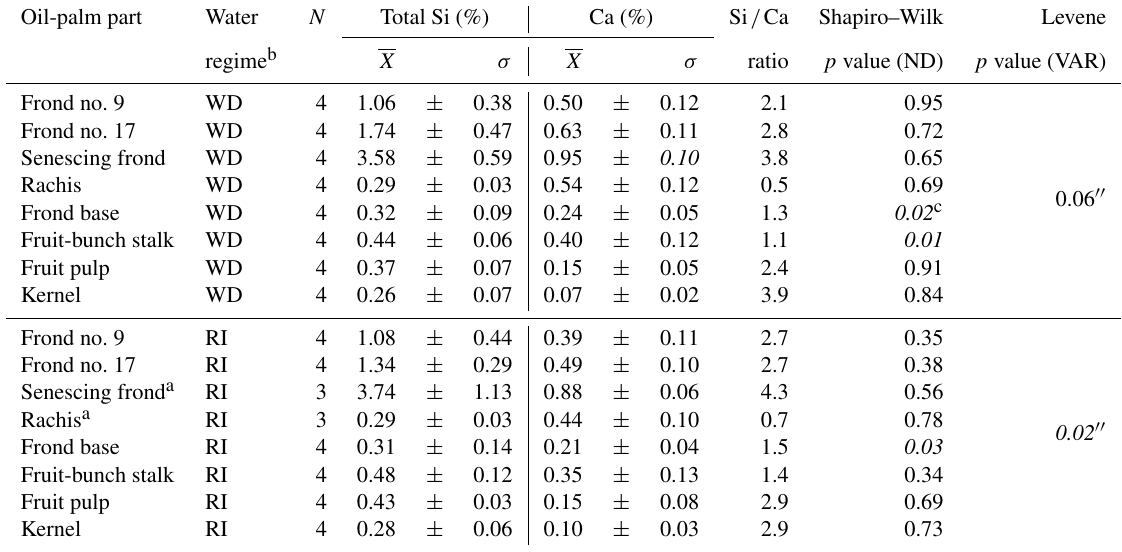
Table B1. Total Si and Ca concentrations in oil-palm parts and statistical